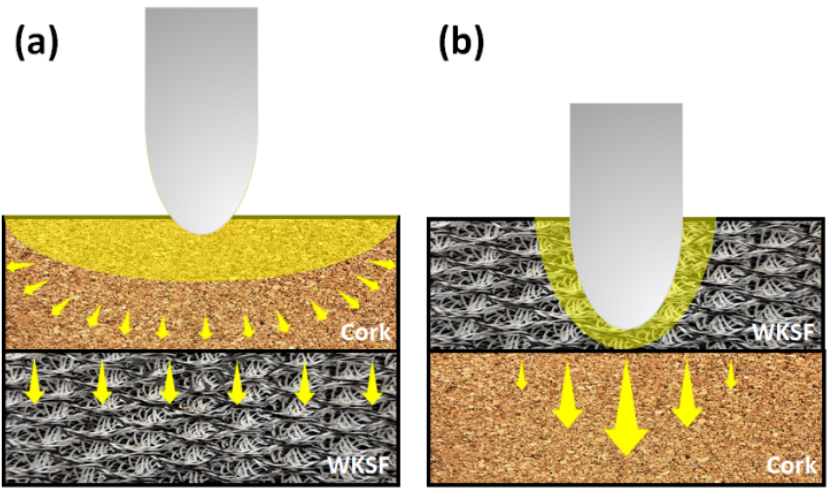
Figure 7. Energy absorbing mechanism in ( a ) cork/WKSF and ( b ) WKSF/cork structures.